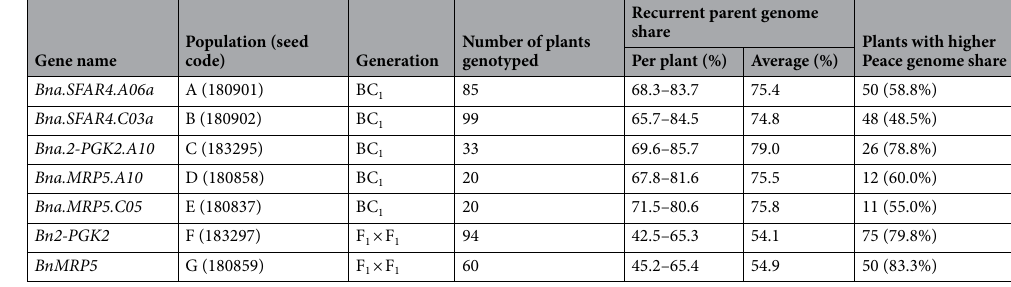
Table 1. Recurrent parental genome contribution in seven BC 1 and F 1 oilseed rape generations. Genome share was calculated as % of the Peace genome. In the last column, plants with a higher Peace genome share were defined as plants with more than the expected